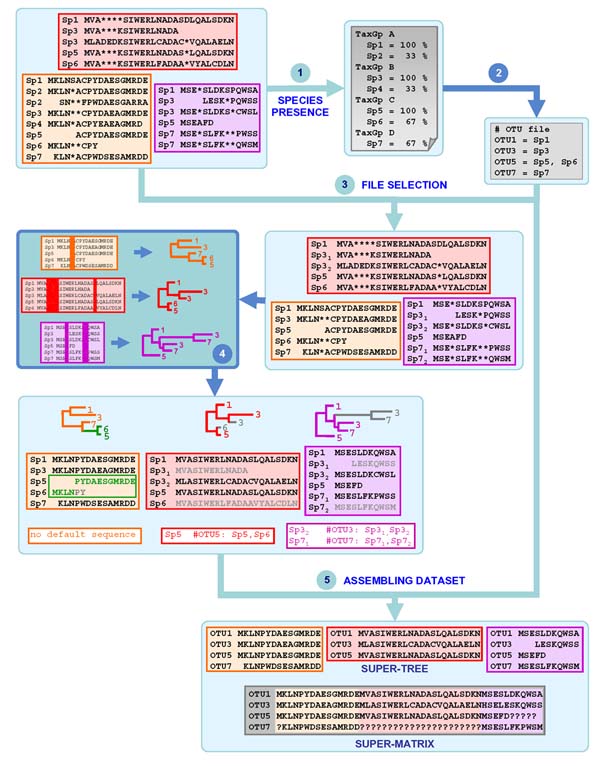
Main steps to use SCaFoS. Steps 1, 3 and 5 are done by SCaFoS: 1. SPECIES PRESENCE: listing of all species present in the files of aligned sequences followed by their frequency of presence and, if desired, classified into taxonomic groups (specified by TaxGp in the figure). 2. Definition by the user of the species to be selected and their respective OTUs 3. FILE SELECTION: creation of files containing only the selected species 4. Discarding ambiguously aligned positions (displayed in dark colour) with a tool such as GBlocks [33]; making phylogenetic trees (using PHYML [34] or PAUP [25] for example) 5. DATASETS ASSEMBLING: selection of sequences and chimera construction according to an OTU file and default sequence files: creation of single gene files including chimeras and selected sequences and creation of concatenated files for super-tree and super-matrix approaches respectively. In the last step, three typical cases are represented: (i) construction of a chimera (OTU5) in the orange file, (ii) selection of the less divergent sequence within an OTU (Sp6 in OTU5) and elimination of a short sequence (Sp31) in the red file and (iii) elimination of potential paralogous sequences by the user (Sp31 and Sp71) in the purple file. Eliminated sequences are drawn in grey. The corresponding default sequences files are displayed under their respective sequence files.